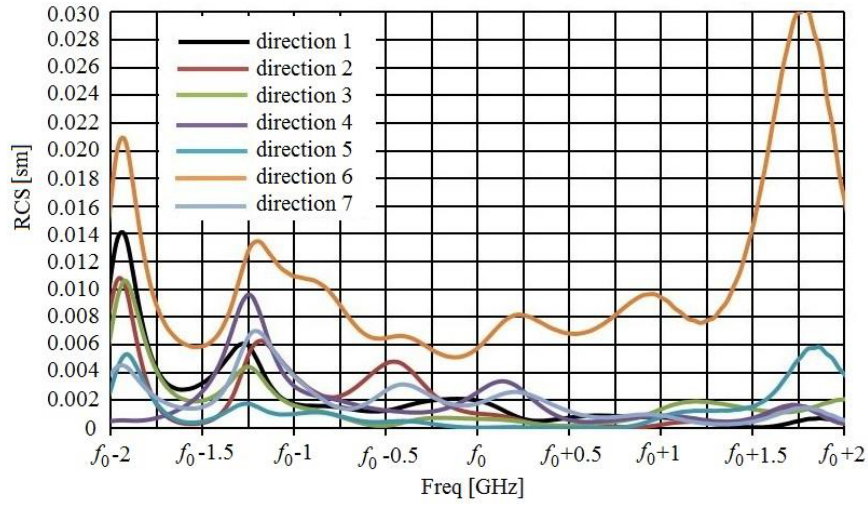
Рис . 8. The RCS of quadrocopter Syma X12 in K a -band at the vertical polarization. The measured quadrocopter Syma X12 RCS is not more than 0.02 m 2 and in average is 0.0032 m 2 for one-side band of 2 GHz from the different radiation directions at the